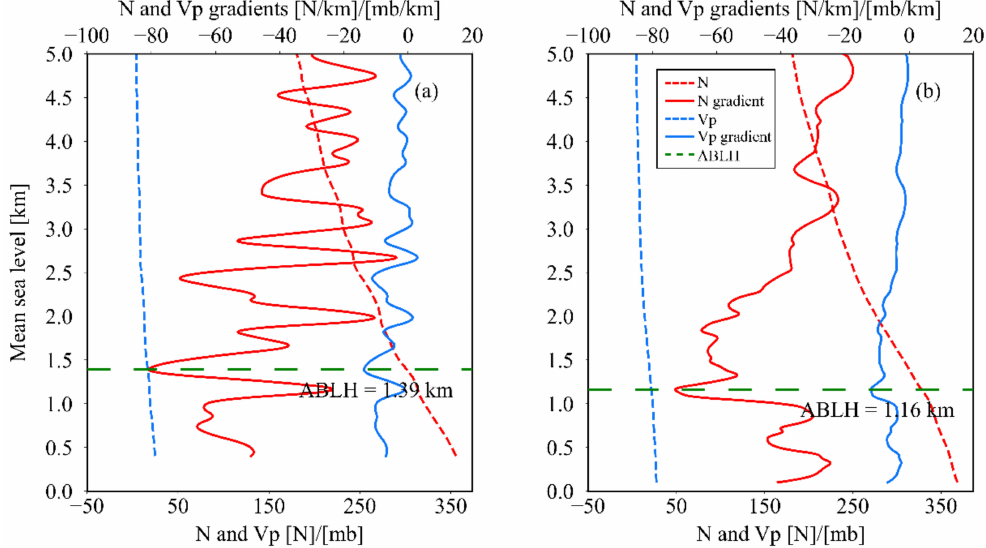
Figure 3. N, Vp, and gradient profiles for RO Profile 1 (( a ) 151.50 ◦ E/17.23 ◦ N, 5 October 2007) and Profile 2 (( b ) 130.64 ◦ E/11.18 ◦ N, 4 October 2020), as well as the results for the